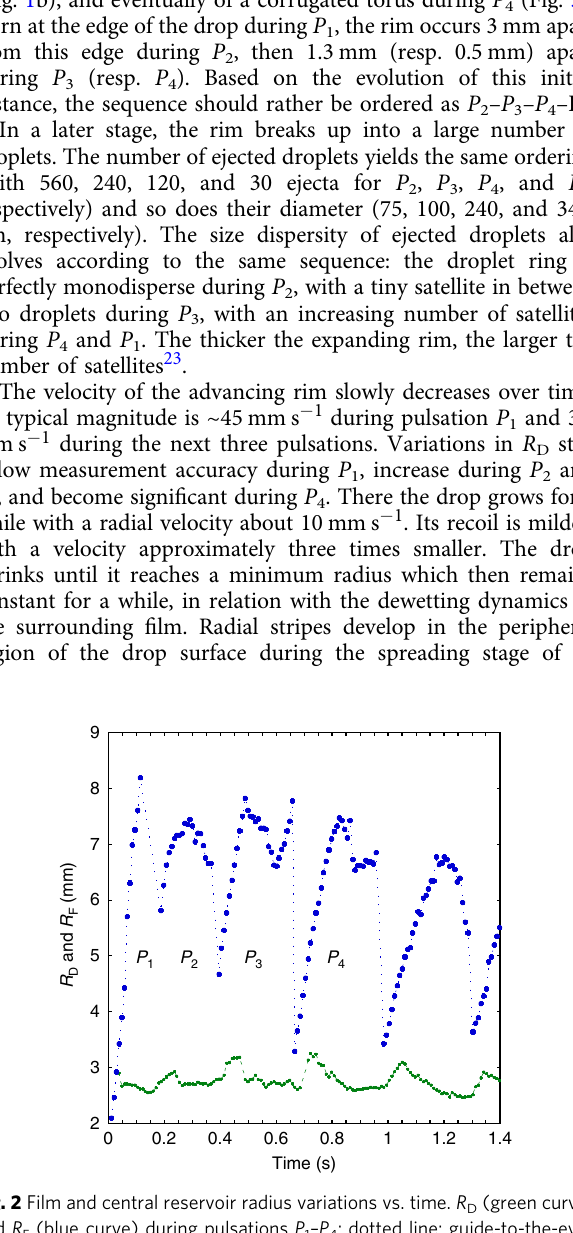
Fig. 2 Film and central reservoir radius variations vs. time. R D (green curve) and R F (blue curve) during pulsations P 1 – P 4 ; dotted line: guide-to-the-eye between experimental points